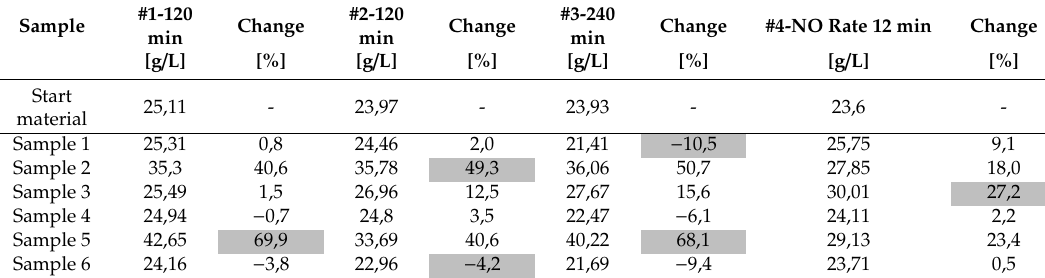
Table 4. Changes in protein titer as CQA measured at 280 nm. Highest changes in titer are again found within the side areas of the freezing chamber. Gray marking highlights the most prominent changes in